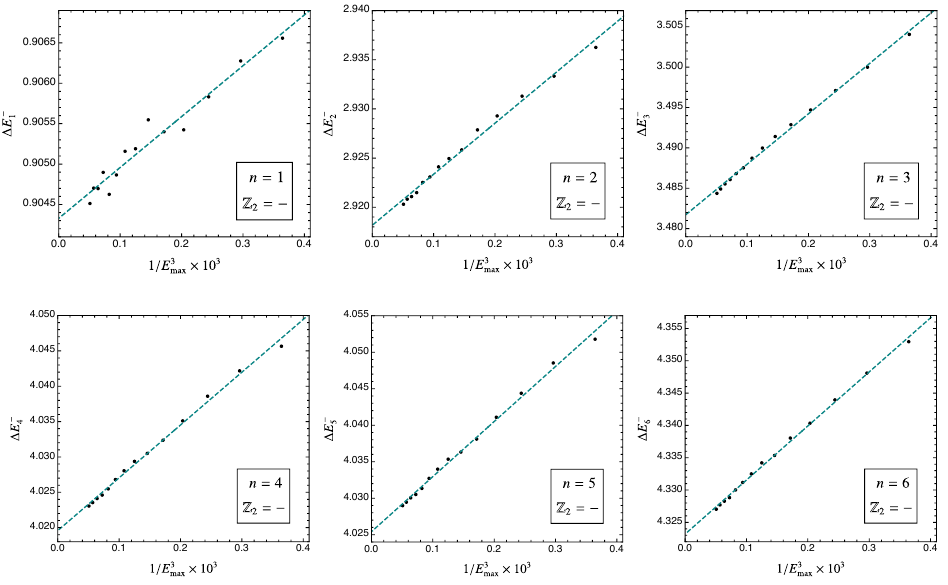
Fig. 5. The excitation energy ∆ E of the first six (cid:90) -odd excited states in the im- n 2 proved theory as a function of 1 / E 3 , including the best fit line. In all panels, max λ/ 4 π = 1, m = 1, 2 π R = NO